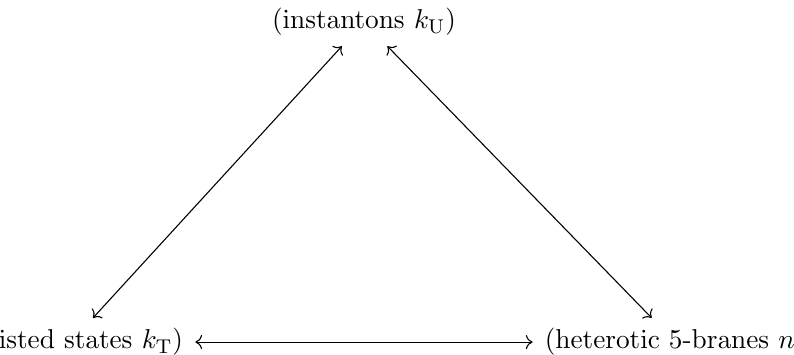
Figure 1 . There are phase transitions among small instantons, heterotic 5-branes and twisted